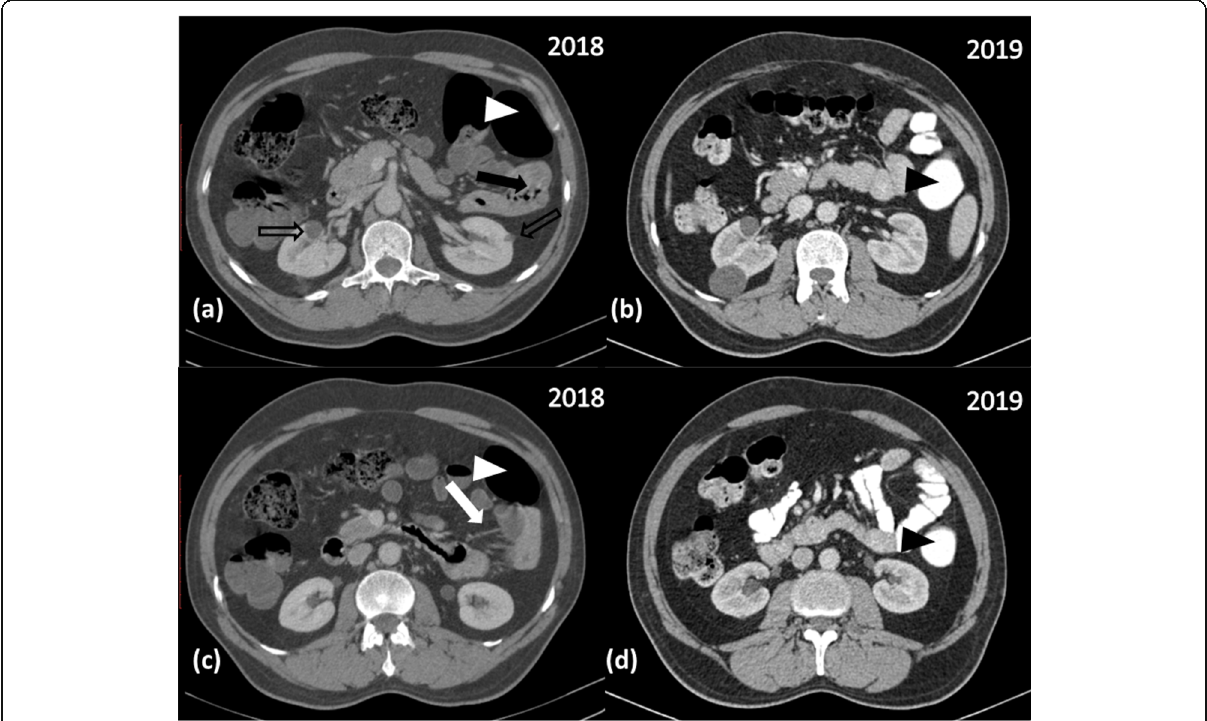
Fig. 1 Contrast-enhanced computed tomography (CECT) axial images of the abdomen in soft tissue window 11 months apart. Images at presentation ( a and c ) show a cluster of small bowel loops seen lying in the left anterior pararenal space (solid black arrow in a ) with anterior displacement of the descending colon (solid white arrowhead in a and c ). Also seen are multiple simple renal cysts in both kidneys (void black arrows in a ). Multiple stretched mesenteric vessels are noted in the mesentery of these bowel loops (solid white arrow in c ). Images after 11 months ( b and d ) show complete resolution of these abnormalities. The descending colon is seen in its expected location in the left anterior pararenal space (solid black arrowhead in b and d